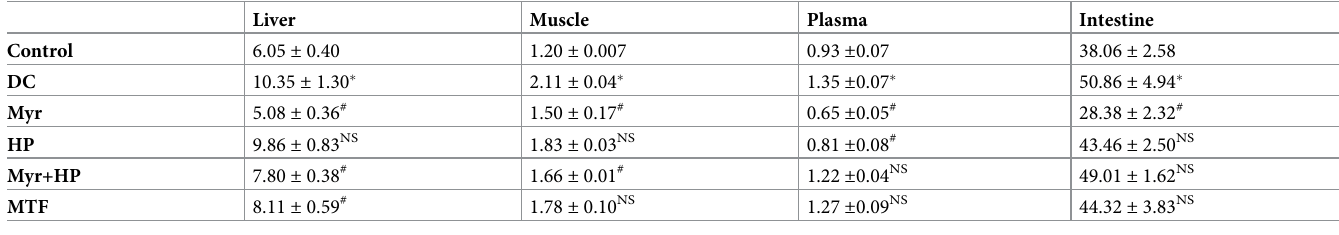
Table 3. DPP-4 activity affected by the presence of Myr and HP ( μ